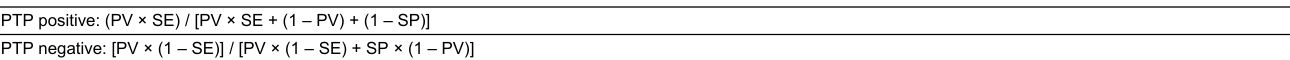
Table 3: Calculation of post-test risk using the Bayes theorem